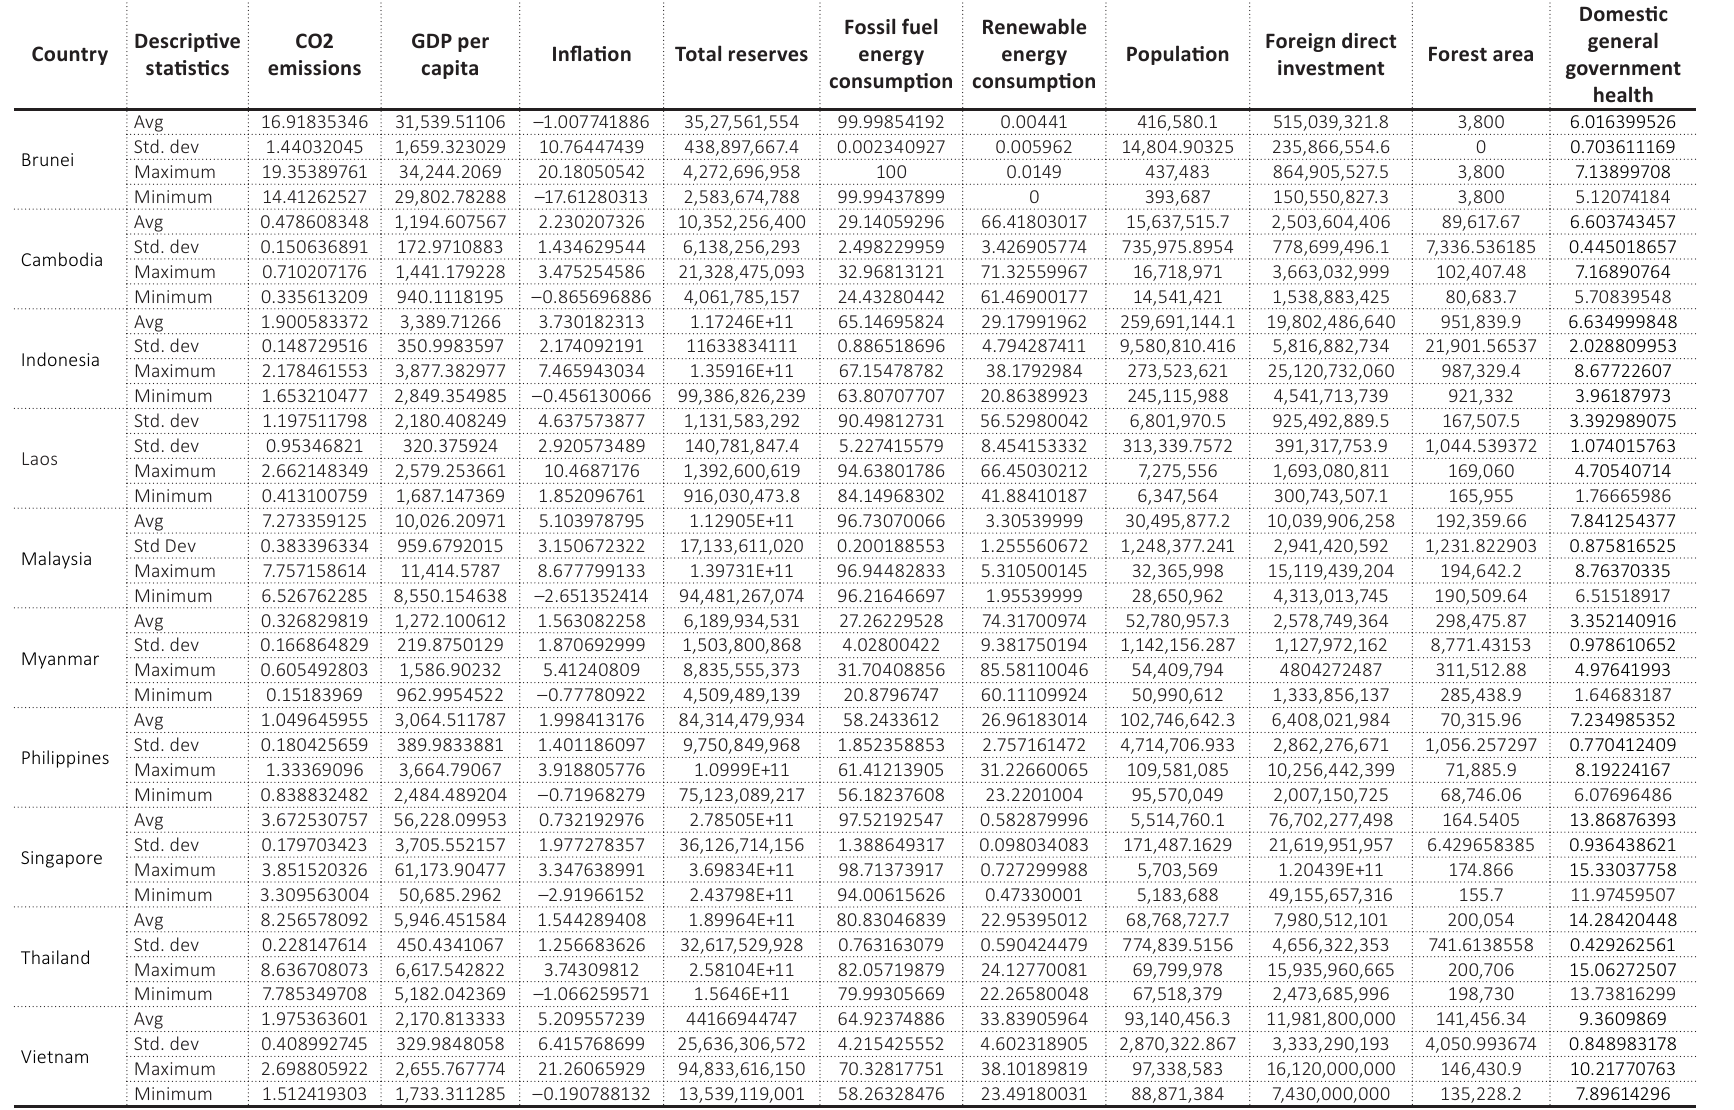
Table 1. Description of research variable data per ASEAN